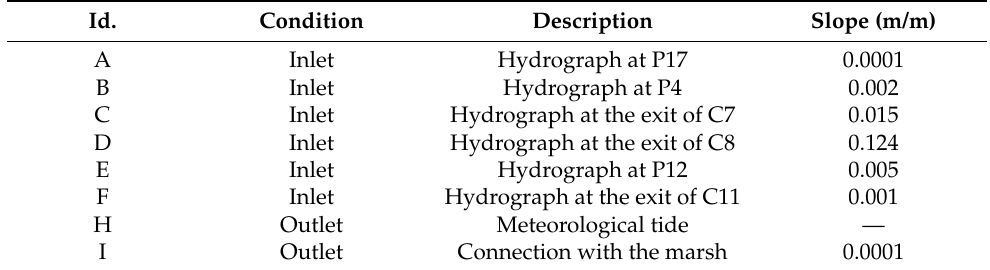
Figure 8. Hydraulic model developed: ( a ) HecRas 2D model with boundary condition (see Table 2); ( b ) DEM shortened and adjusted to the coastal strip used in the simulations; ( c ) net rainfall for a return period of 25 years; ( d ) mesh structure around the “Junction” point. All maps are oriented to the North. An extended larger version of Figure 8a can be found int the Supplementary Material. Table 2. Boundary conditions established in the hydraulic model (see Figure